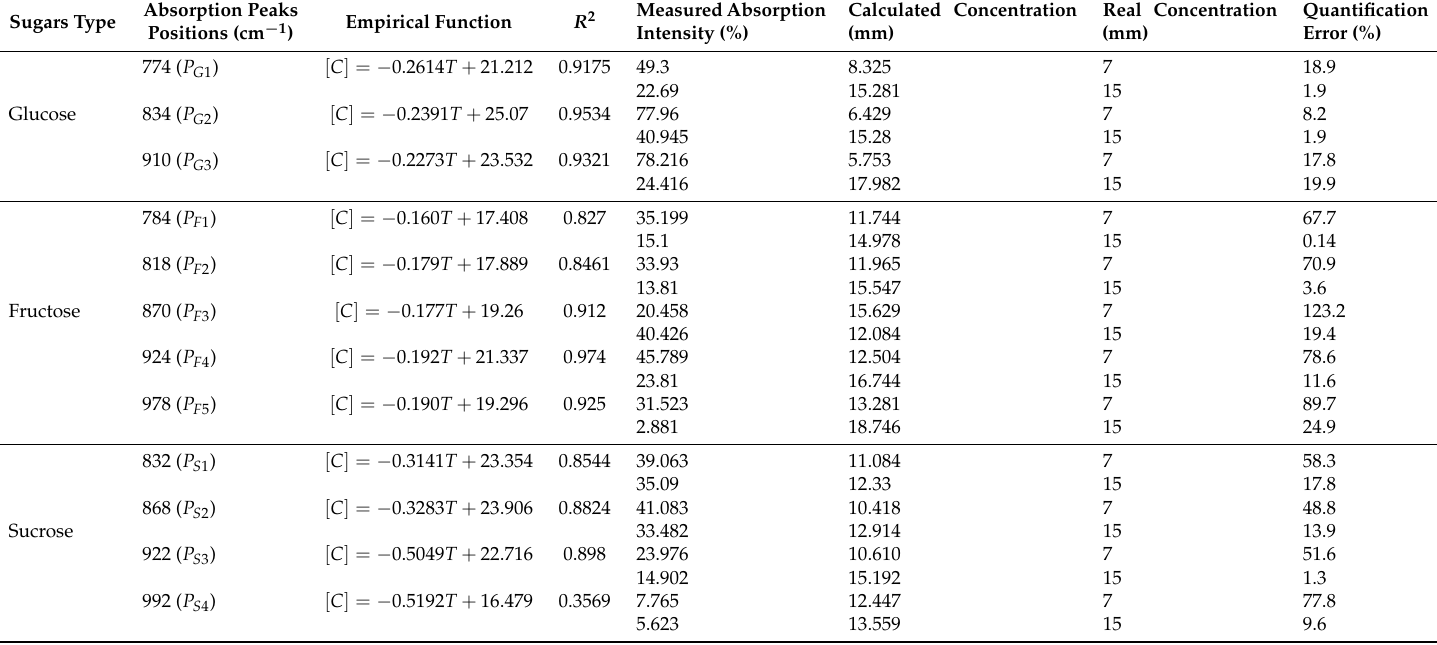
Table 3. Absorption peaks characteristics and quantification results of unknown solution concentration based on linear